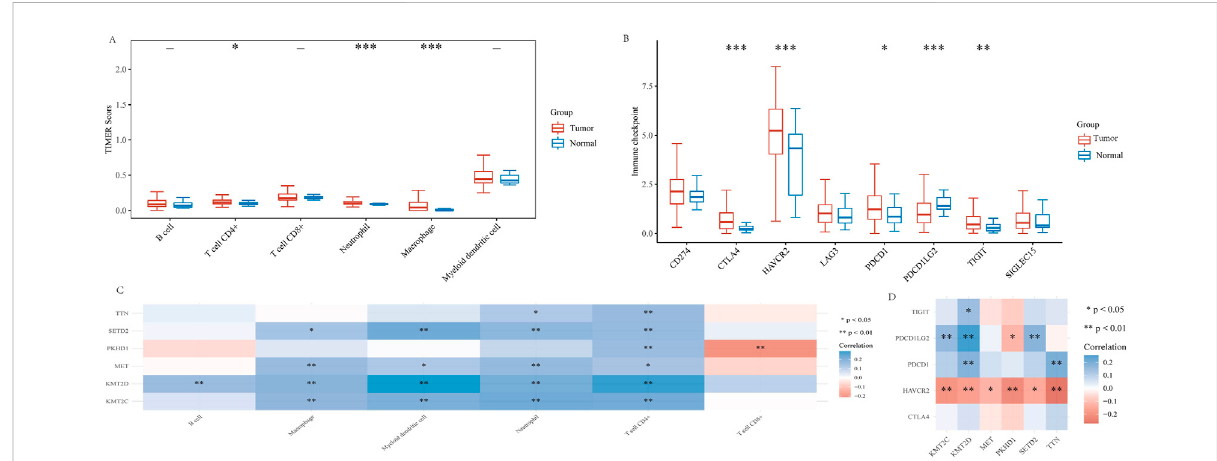
FIGURE 10 High mutant genes and KIRP tumor immunoassay. (A) In patients with KIRP, the TIMER algorithm was used to observe differences in immune cells in tumor versus normal tissue. (B) Different expressions of immune checkpoints in tumor tissue and normal tissue in KIRP (* p < 0.05, ** p < 0.01, *** p < 0.001, asterisks (*) stand for signi fi cance levels. (C) The correlation between six high-mutation genes and immune in fi ltration. (D) The correlation analysis between six high-mutation genes and immune checkpoints. (* p < 0.05, ** p < 0.01, *** p < 0.001, asterisks (*) stand for signi fi cance